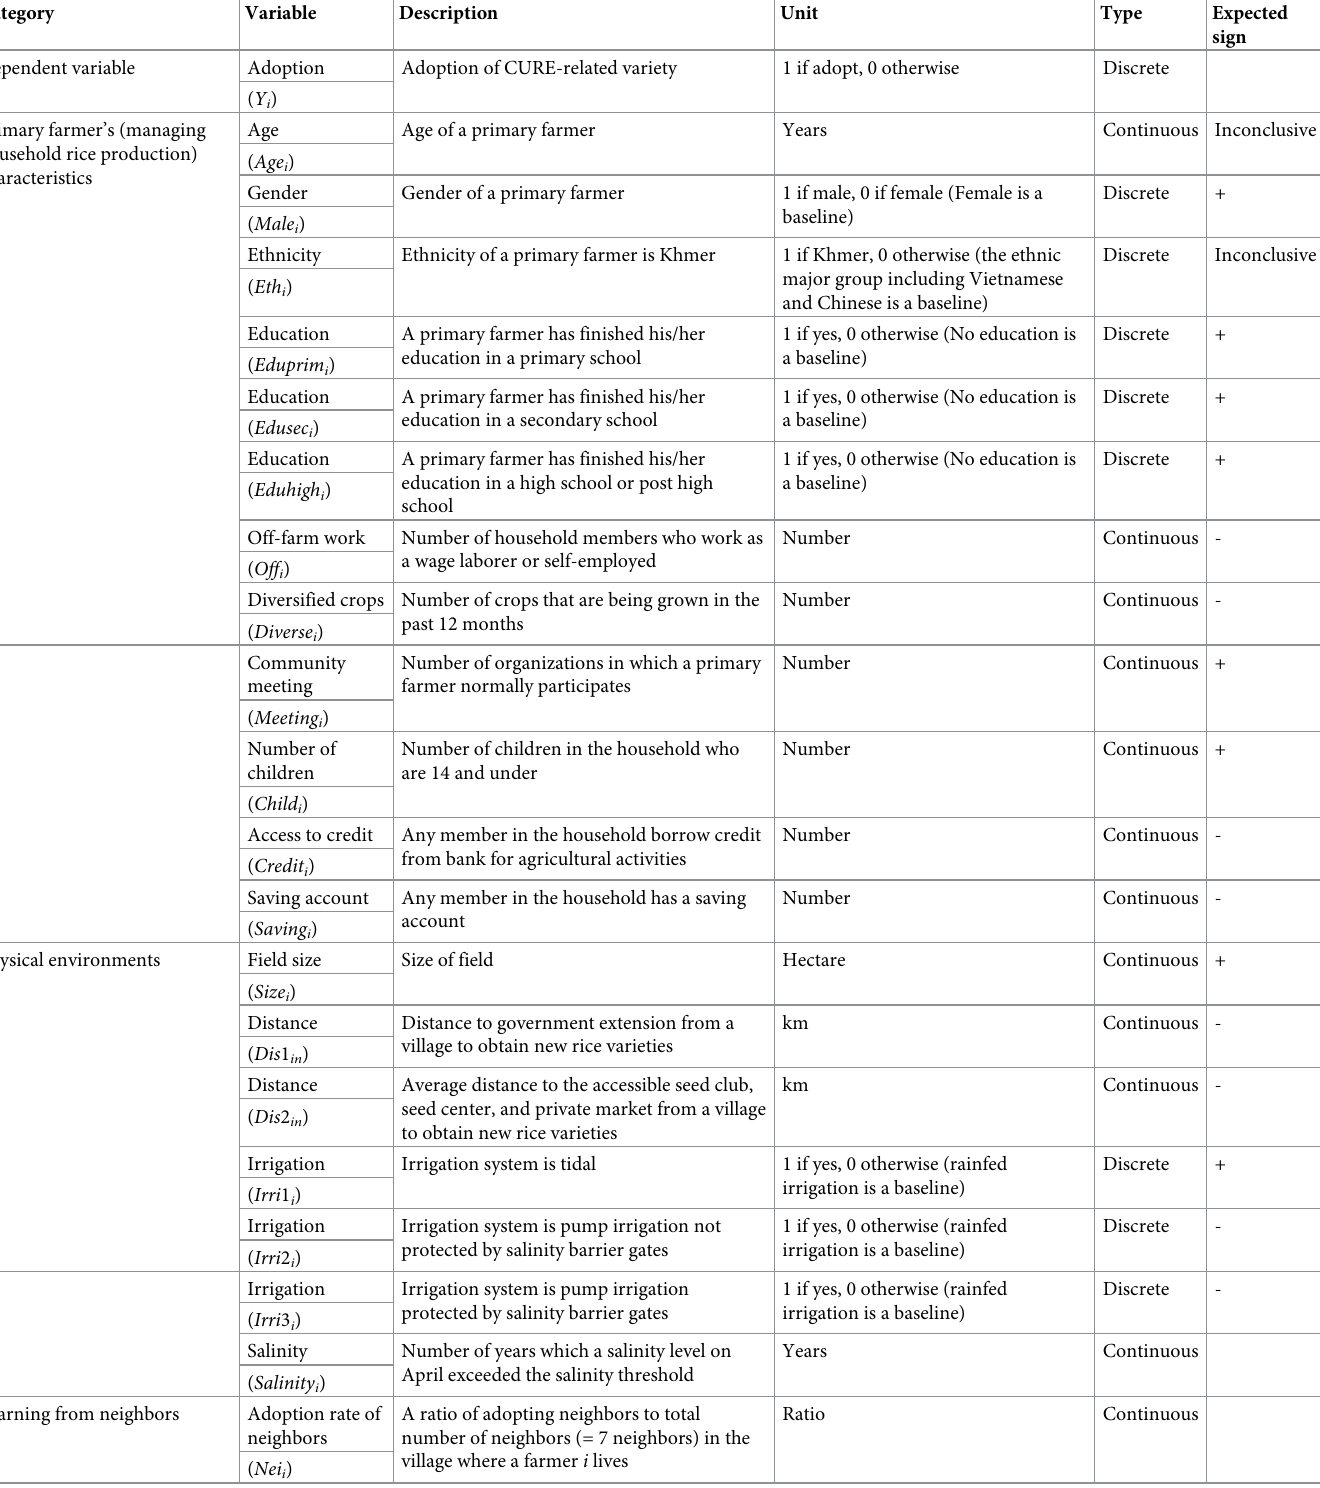
Table 1. Description of the study